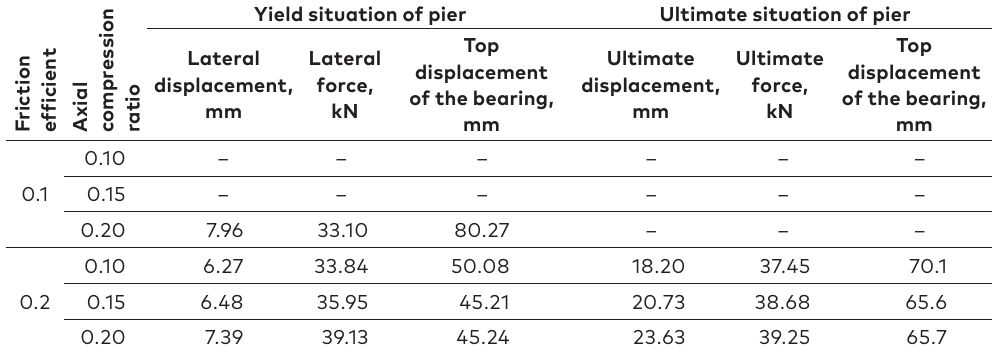
Table 4. Horizontal force of the series system